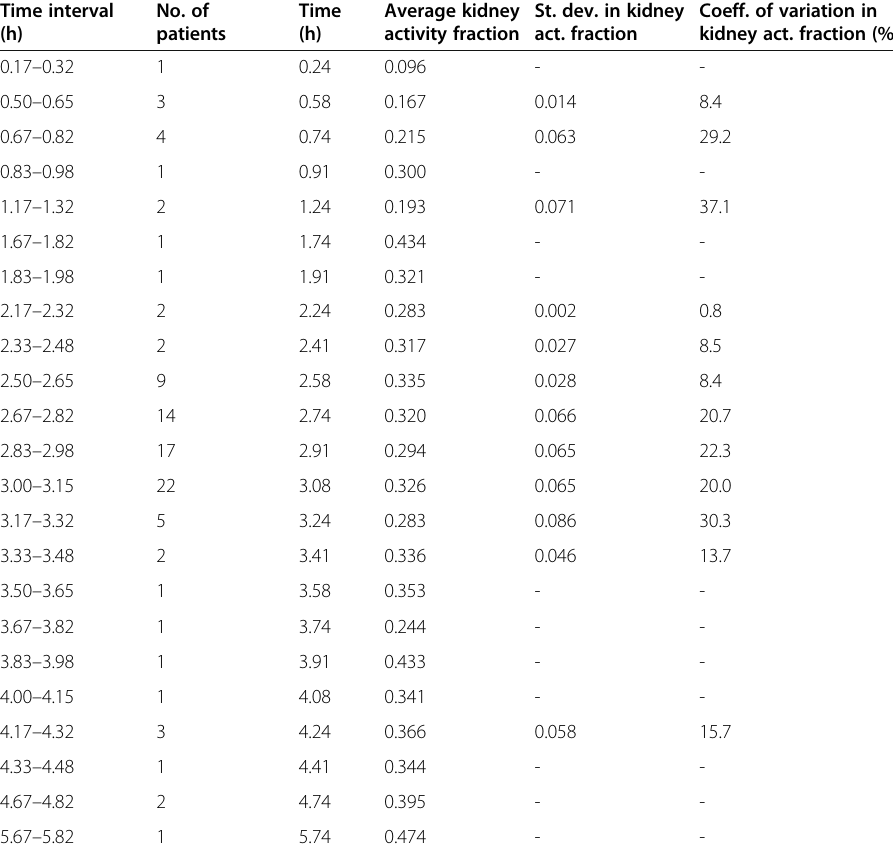
Table 1 Binned kidney activity fraction data used to fit expression 1 (from retrospective data analysis) Time interval No. of (h)